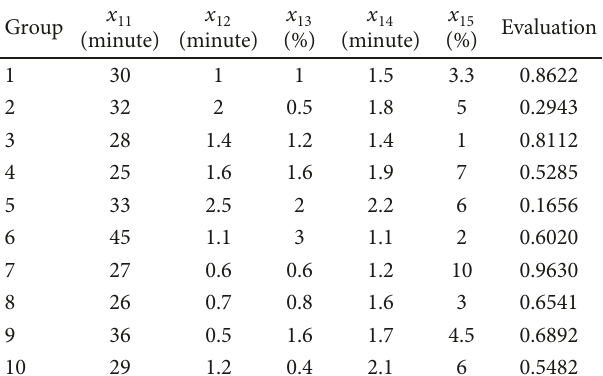
Table 6: Support, ejection, and recovery